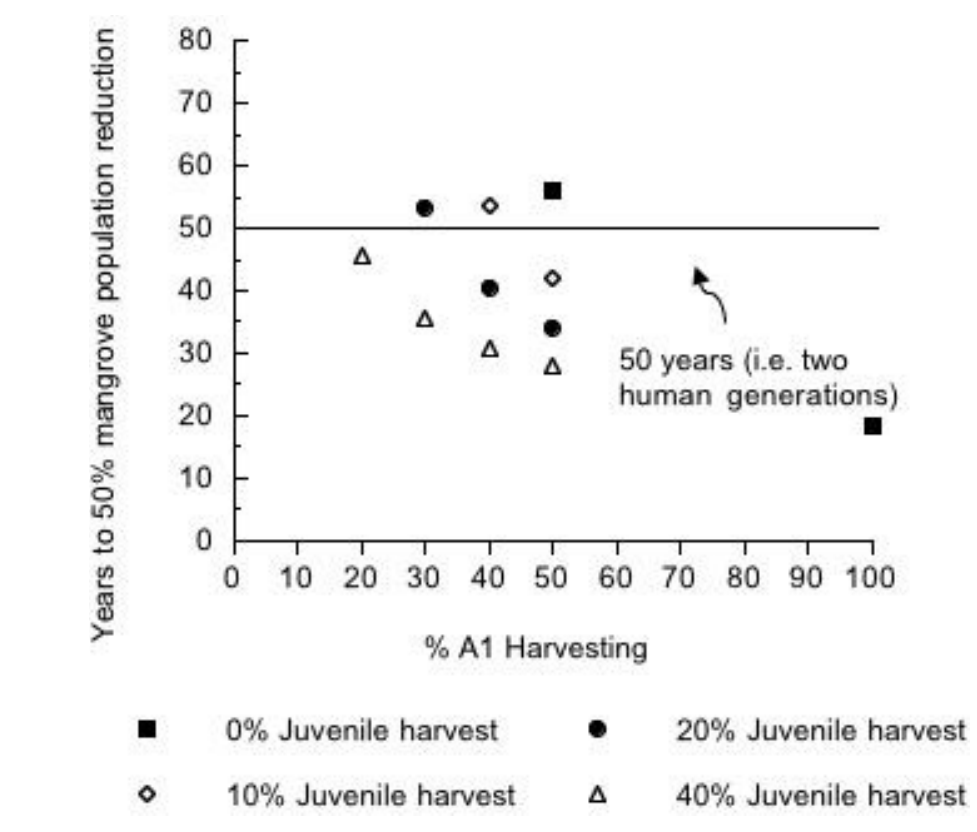
Fig. 7. The number of years of sustained harvesting that can be applied before causing a 50% reduction in mangrove population numbers. The analysis considers only those harvesting levels in Fig. 6 that were considered statistically unsustainable, i.e., both mean l and 95% CIs are entirely below 1. Using the criteria of sustaining 50% of the population for 50 yr, three harvesting levels that were considered ecologically unsustainable according to the analysis in Fig. 6 might be considered sustainable according to the harvesters’